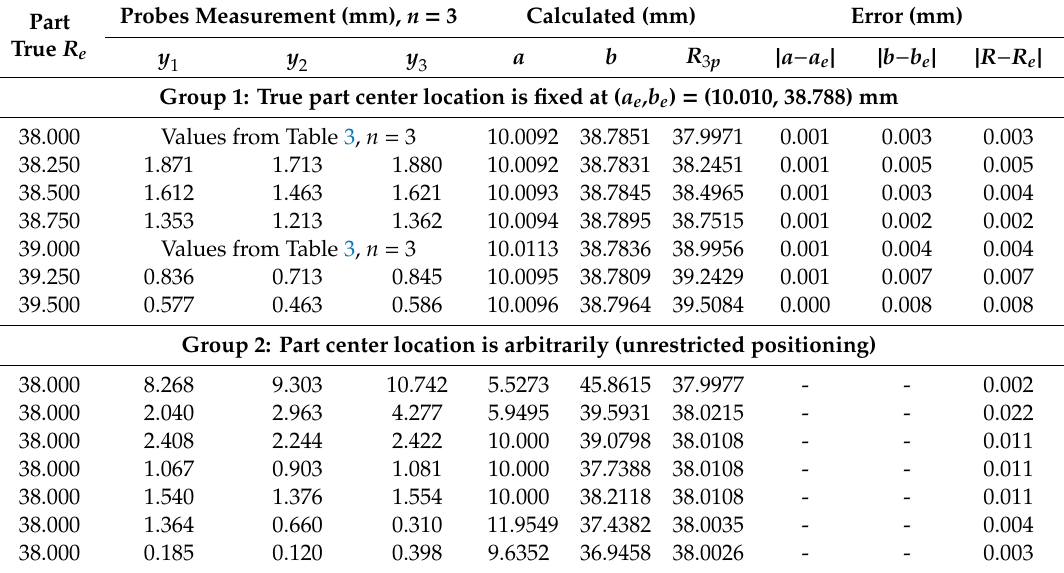
Table 6. TPFK algorithm based on CAD simulation is studied for two groups of